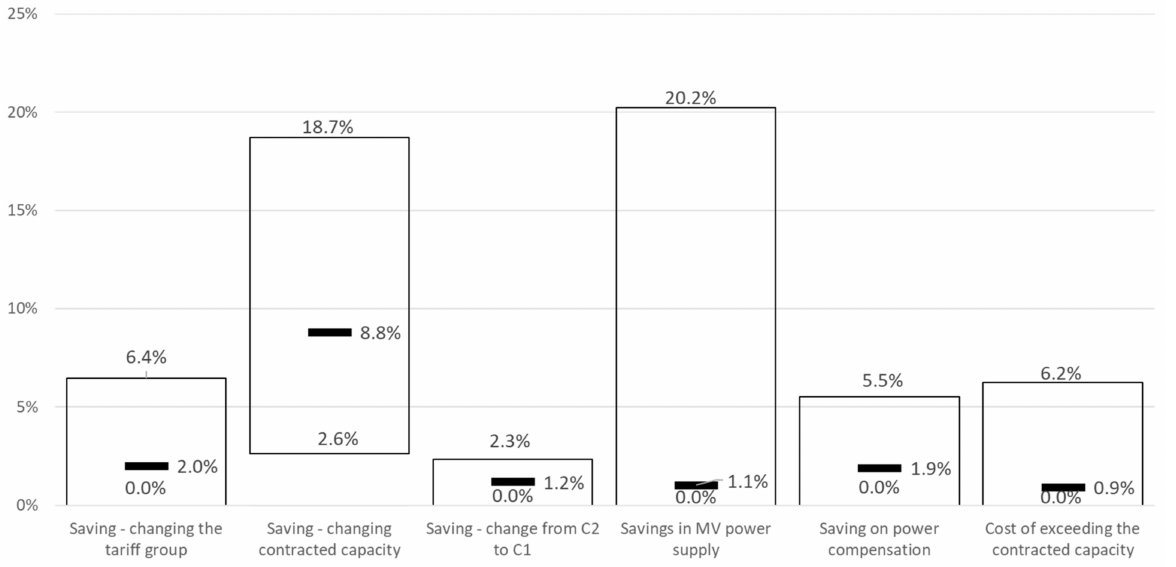
Figure 1. Minimum, average, and maximum level of savings within a given category—electricity. The group of costs related to contracted capacity has the largest share in the total amount. Savings in this group amount to PLN 3.056 million, the second largest group of savings is the group of costs related to changing the tariff group (PLN 0.7 million), and the next group of savings is related to the installation of equipment for the compensation of reactive power (PLN 0.662 million). The savings that can be obtained in individual communes are presented below (Figure